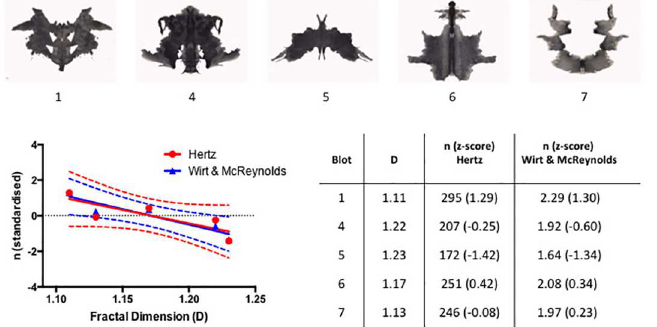
Fig 6. Number of percepts, n , induced by the five black blots plotted as a function of the D value of their boundaries. The inset tabulatesthe D values of the five blots alongwith the corresponding data from Hertz [5] and Wirt and McReynolds [21] respectively. For the purposeof direct comparison, the raw n scores have been standardized as z-scores and are shown in parentheses. The horizontaldotted line represents the mean score for each of the two sets of data. The red and blue lines are linear fits to the respective data and the dashedlines represent the boundariesof 95% confidenceintervals. Note that three of the blue data points (for Blots 1, 5 and 6) are obscured by the equivalentred